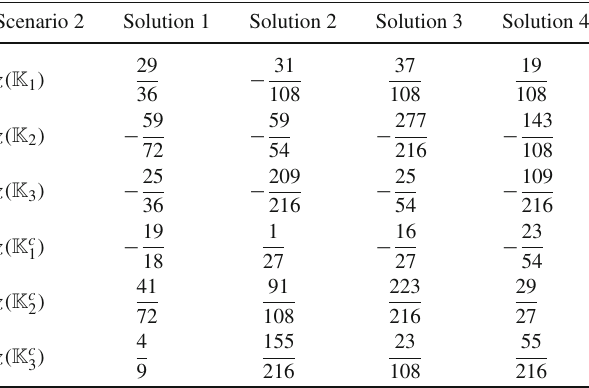
Table23 Valuesofthe U ( 1 ) (cid:2) chargesfortheexoticquarksinU μν SSM models using solution (29) with the hypercharges of Table 4. For each column, the U ( 1 ) (cid:2) charges of the rest of the fields are given in Table 2 and Scenario 2 of Table 3. The minimal number of singlets under the SM gauge group consistent with these charges is n ν c = 3 , n S = 2